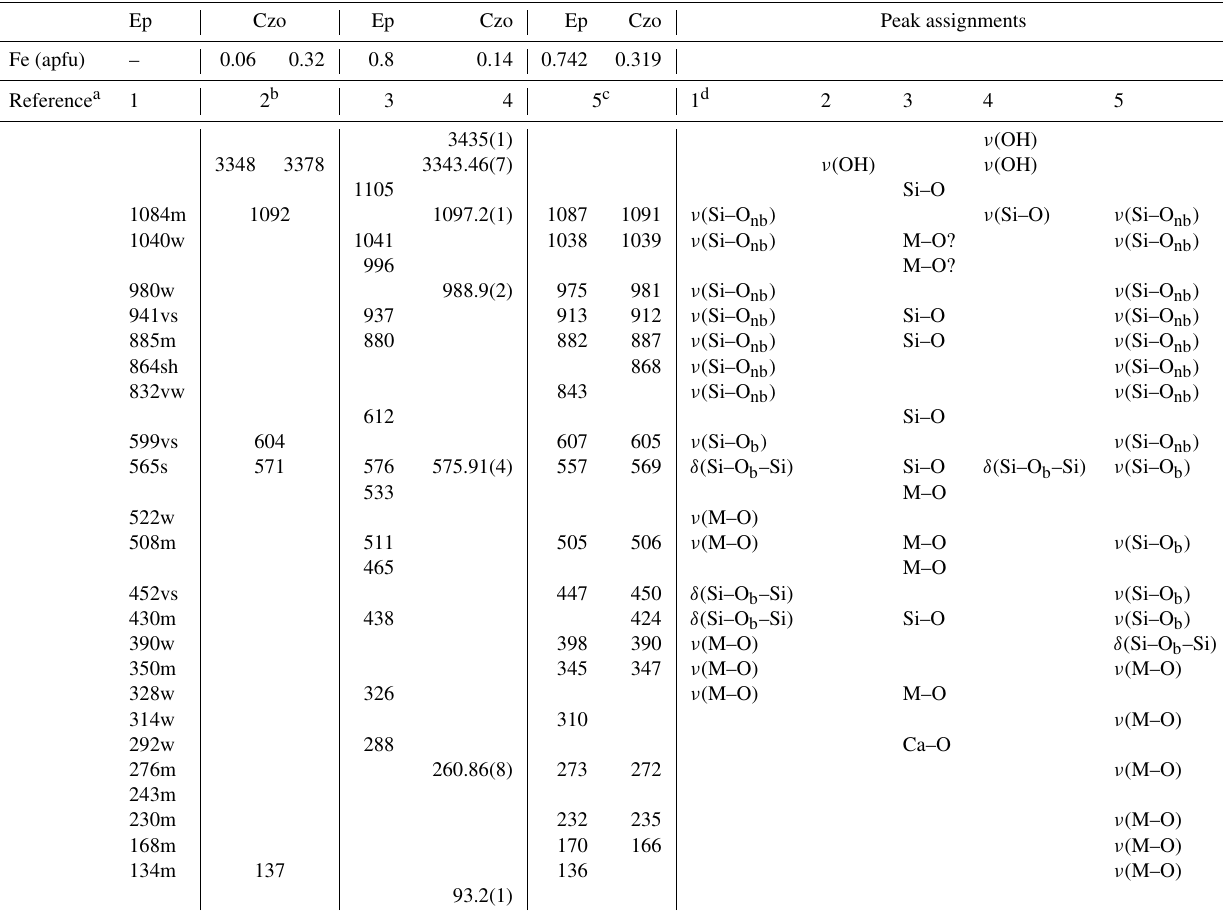
Table 1. Previously reported Raman peak positions and the peak assignment of Raman spectra of the Al–Fe 3 + series of epidote, Ep, and clinozoisite,